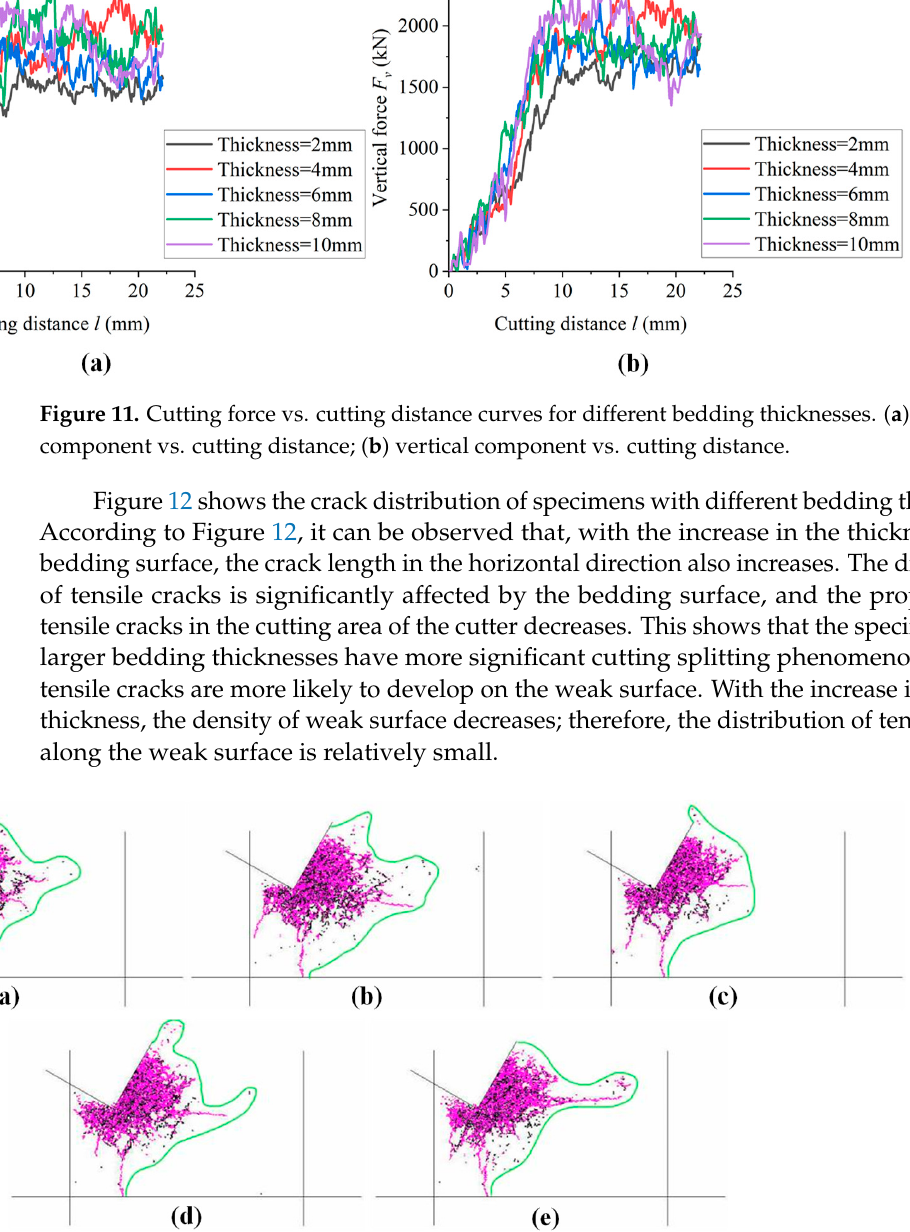
Figure 12. Schematic diagram of crack distribution of specimens with different thicknesses: ( a ) 2 mm; ( b ) 4 mm; ( c ) 6 mm; ( d ) 8 mm; ( e ) 10 mm. (Purple represents shear crack, black represents tensile crack, and the range of green curve envelope represents crack growth area.)